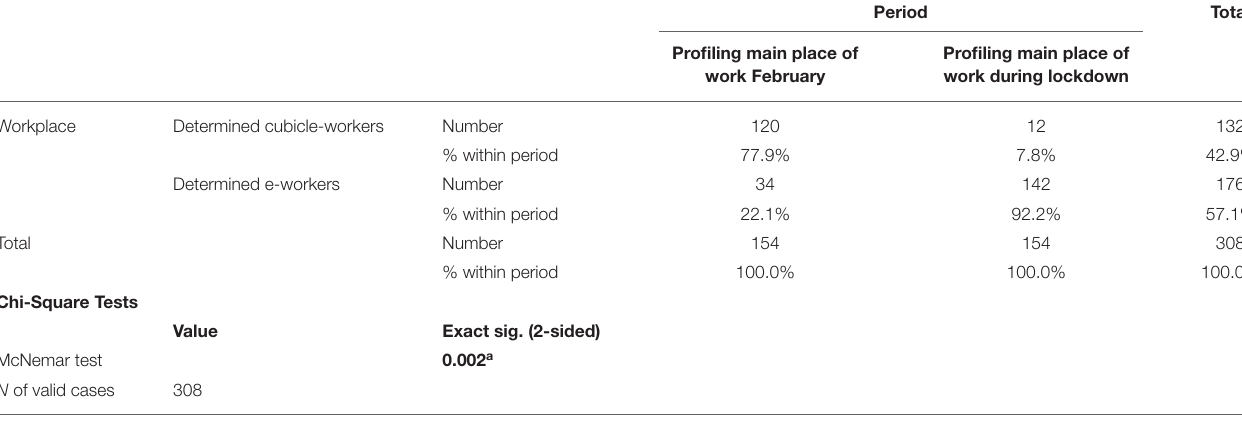
TABLE 6 | Workplace * Period Cross-tabulation and Chi Square tests.